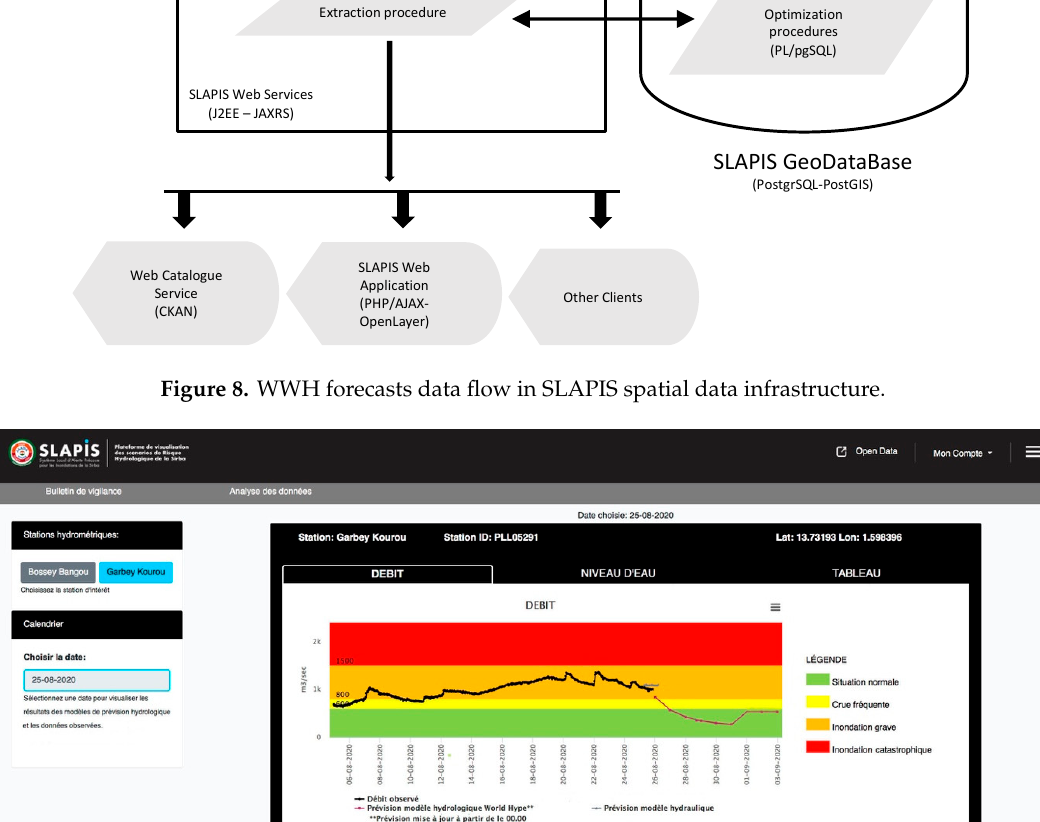
Figure 9. User interface of SLAPIS platform with hydrograph of observed and forecasted discharge in Garbey Kourou the 25 August 2020. The black line is the observed flow, the grey line is the hydraulic forecast, and the red line the WWH optimized forecast.